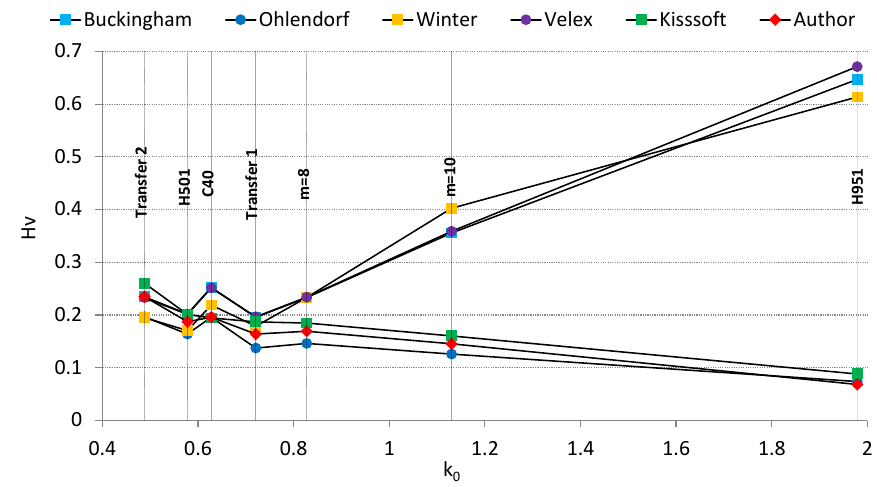
Figure 2. Gear loss factor comparisson with different